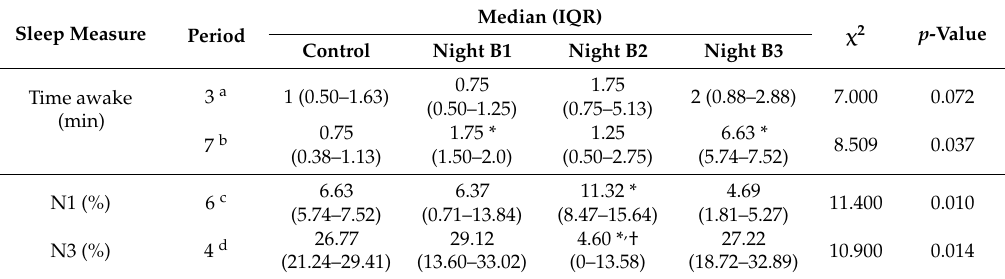
Table 6. Objective sleep variables where a main effect of WTN sound character period was found in Study B.